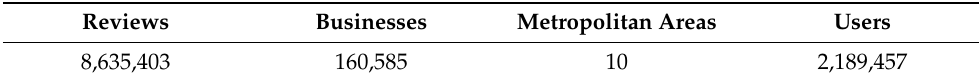
Table 3. Yelp Dataset